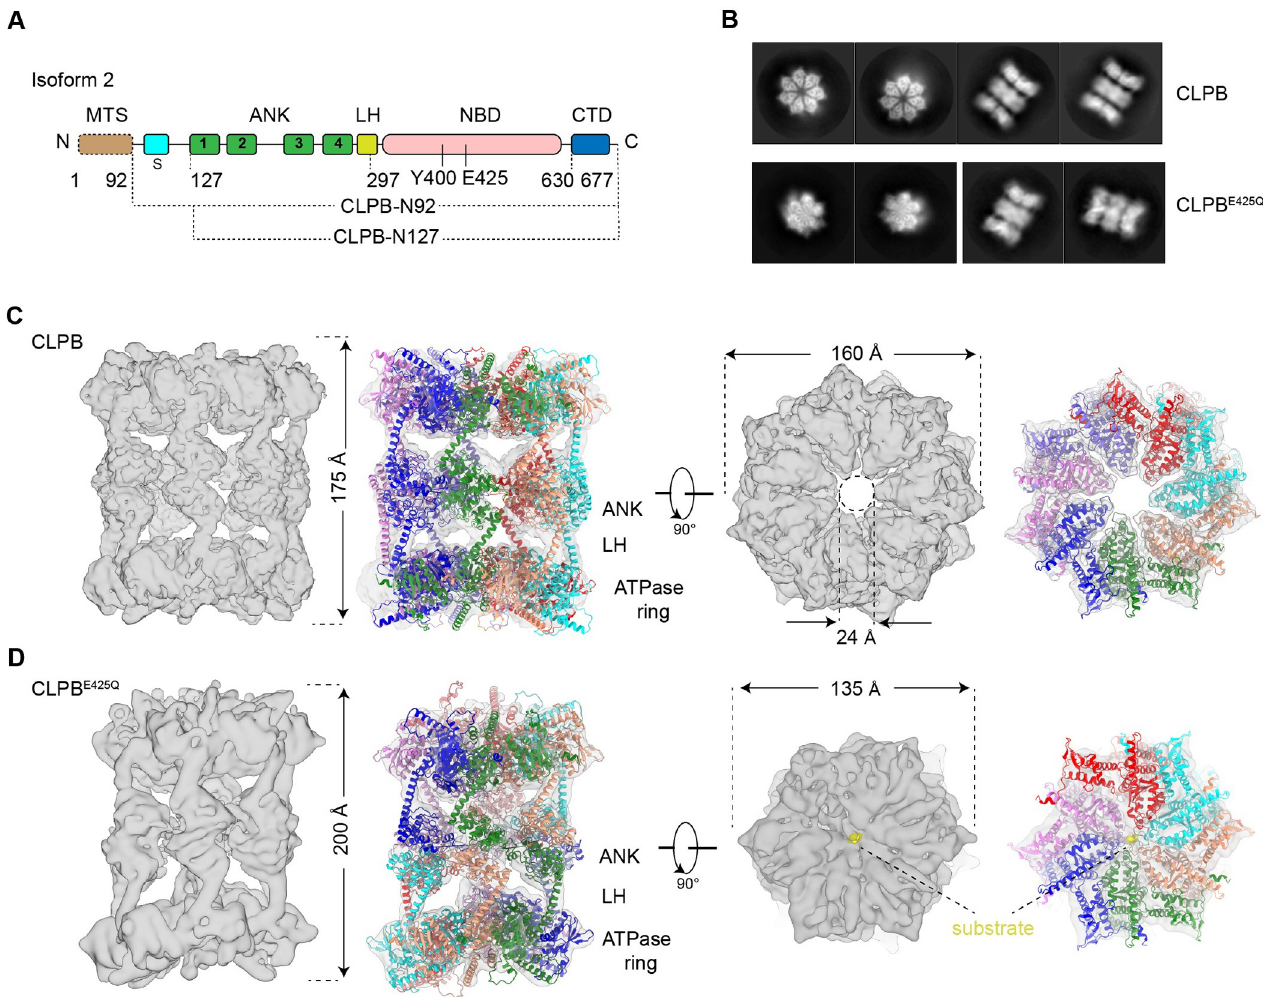
Fig 1. Cryo-EM structures of the CLPB double-heptamer in the apo-state and the CLPB E425Q double-hexamer in the substrate-bound state AU : AbbreviationlistshavebeencompiledforthoseusedinFigs 1 ; 2 ; and 4 to 7 : Pleaseverifythatallentriesarecorrect : . ( A ) Domain organization of H . sapiens CLPB. CLPB is composed of an MTS, a short hydrophobic stretch (S), an LH, 4 ankyrin-repeat (ANK) motifs, an NBD, and a CTD. ( B ) Representative 2D classification averages of CLPB and CLPB E425Q datasets. ( C , D ) The density maps of the double-heptamer (C) and double-hexamer (D), superimposed with the models of CLPB. The density maps are shown in the side and top (ATPase ring) views. The higher-order oligomer is mediated by ANK domains. The substrate was labeled as yellow. LH, linker helix; NBD, nucleotide-binding domain.